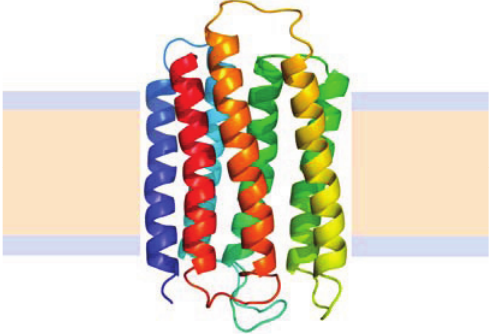
Figure 6. Structure of Bacteriorhodopsin from Halobacterium salinarum (Protein Data Bank ID 2BRD). Alpha helices are represented by coiled ribbons, and protein loops are shown as thin lines. The beige area represents the hydrophobic core of the membrane, while the light-indigo regions refer to the hydrophilic head groups of